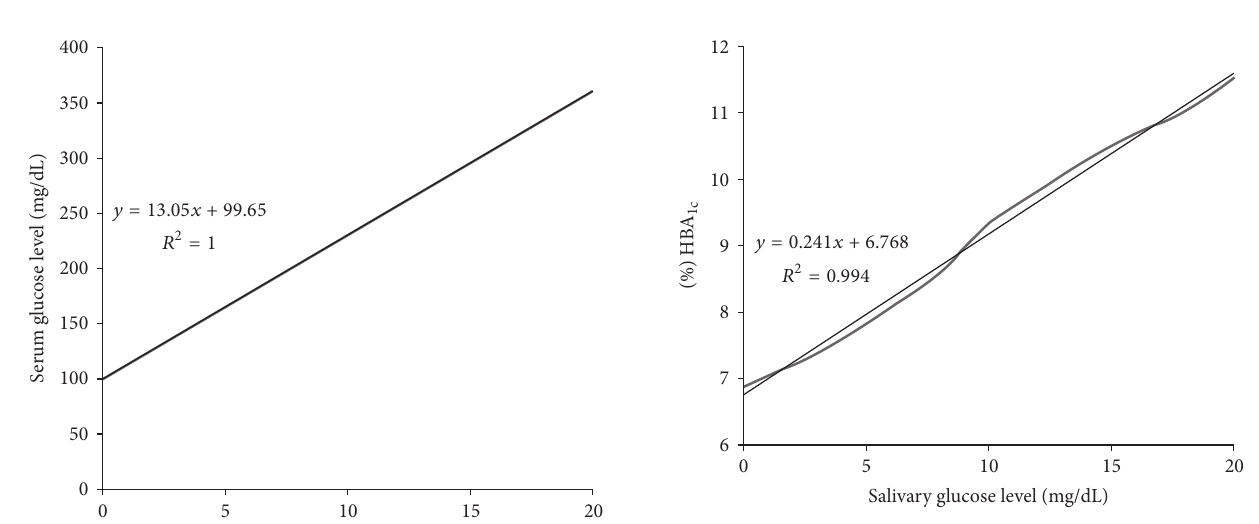
Figure 2: Correlation between preprandial salivary glucose levels and glycated hemoglobin (HbA 1 c ) percentages in the study group ( 𝑝 < 0.001 ). level (mean = 27, median = 27, 28.4%, 𝑝 = 0.041 ).